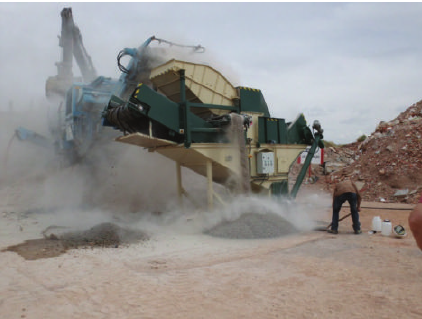
Figure 1: Recycling railway sleepers process.